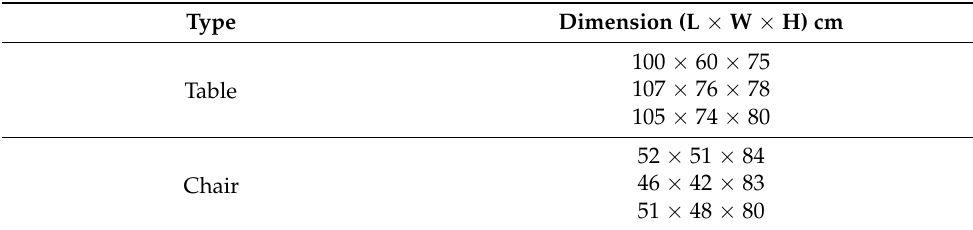
Table 5. Dimensions of existing tables and chairs in the market.